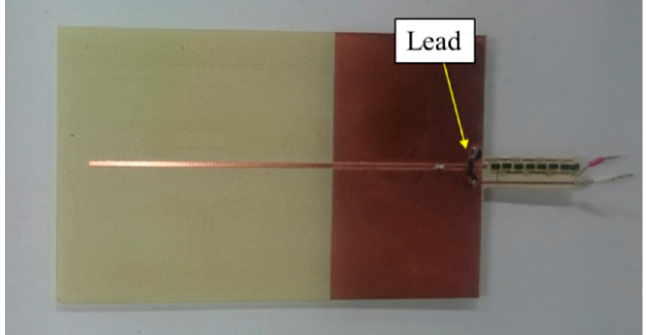
Figure 20. Photograph of the fabricated antenna with the impedance matching antenna.